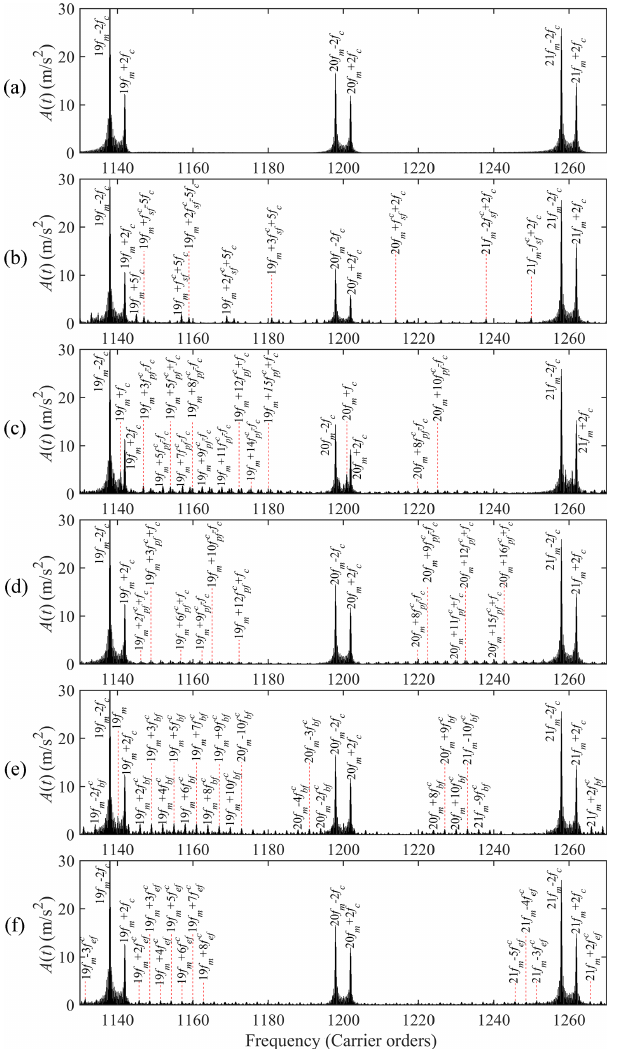
Figure 8. Frequency spectrum of synthetic vibration signals: (a) healthy gear case, (b) failure case I, (c) failure case II, (d) failure case III, (e) failure case IV, and (f) failure case V.